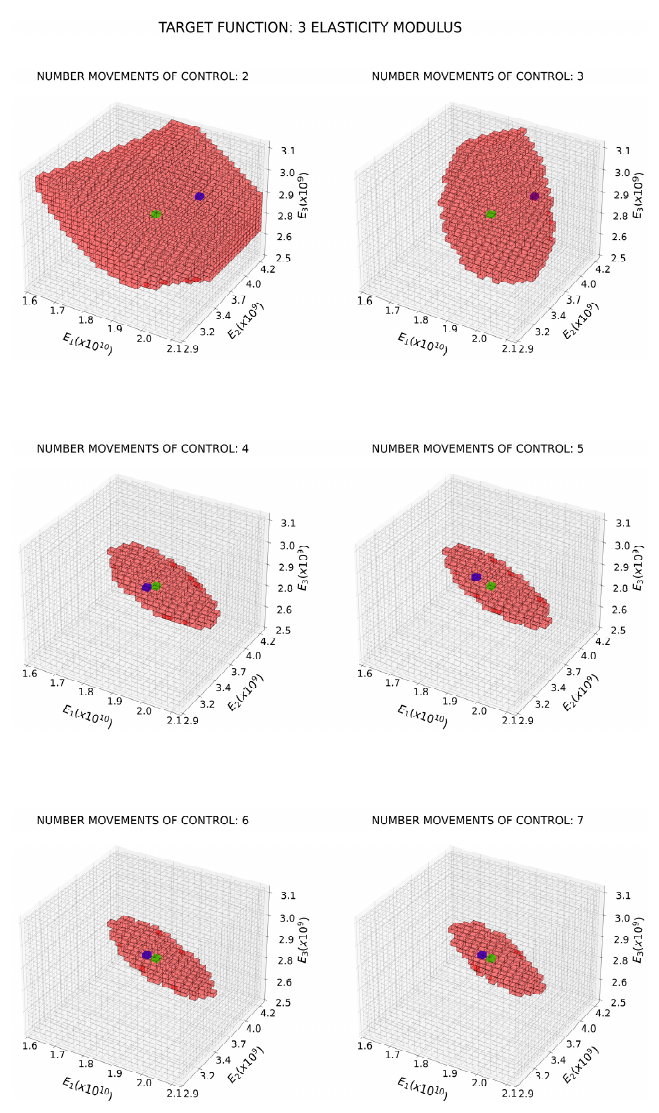
Figure 7. Calibration of the dam and the foundation, divided into riverbed and abutments, with a different number of control movements. (E 1 modulus of elasticity of concrete (Pa), E 2 modulus of elasticity for the riverbed (Pa), and E 3 modulus of elasticity for the abutments (Pa)). The green cube represents the volume in which the exact solution is placed. The blue cube is the volume where the result of the optimization process is